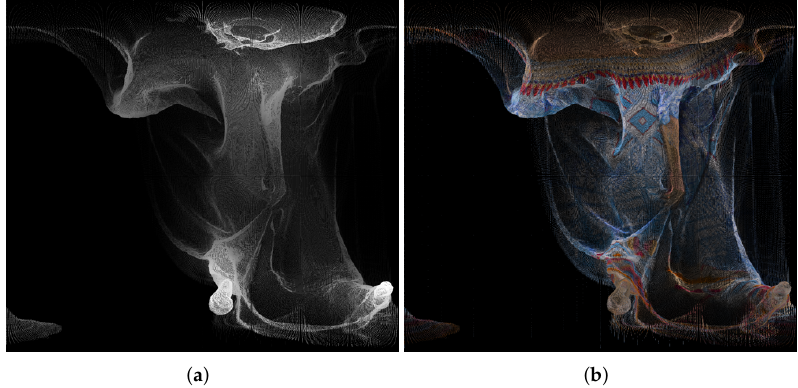
Figure 7. Panorama images created using point cloud “longdress_vox10_1060.ply” from the Miller projection, for the geometry ( a ) and texture ( b